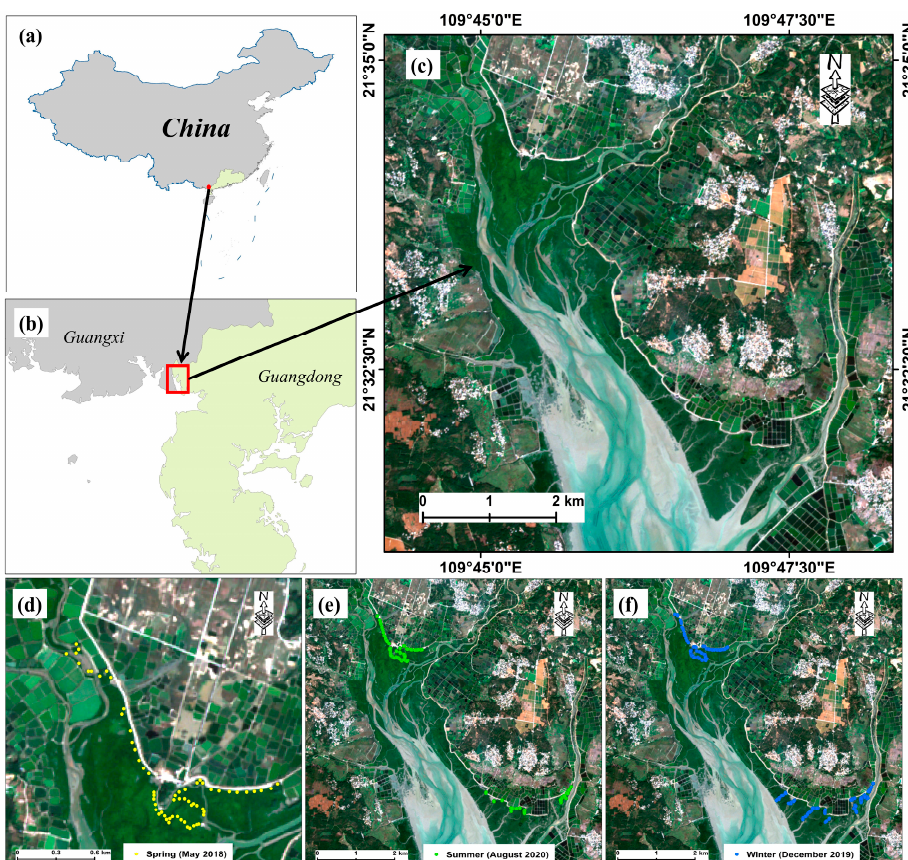
Figure 1. Study area ( a – c ) and spatial distribution of sampling plots in three seasons ( d – f ) (spring: 22–26 May 2018; winter: 20–28 December 2019; summer: 6–12 August 2020). The true-color image is based on the Sentinel-2 image (date: 24 November 2019) with a color combination of band 4 (red), band 3 (green), and band 2 (blue). Table 1. Number of plot samples collected in three seasons.